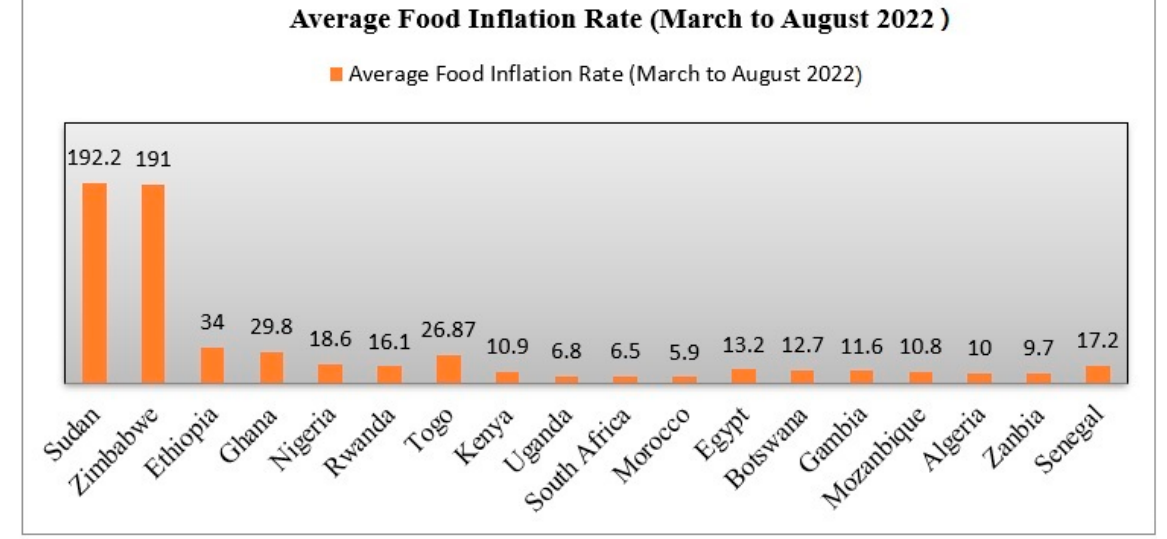
Figure 8. Average inflation rates of some African countries (March to August 2022). Source: Trading economics, 2022.